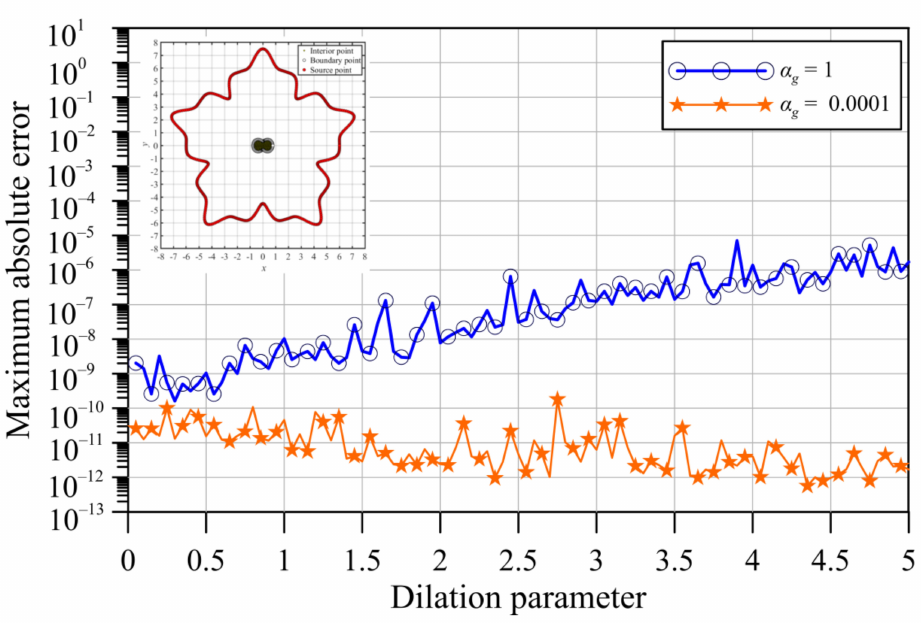
Figure 16. Maximum absolute error versus the dilation parameter ( k = 4 )